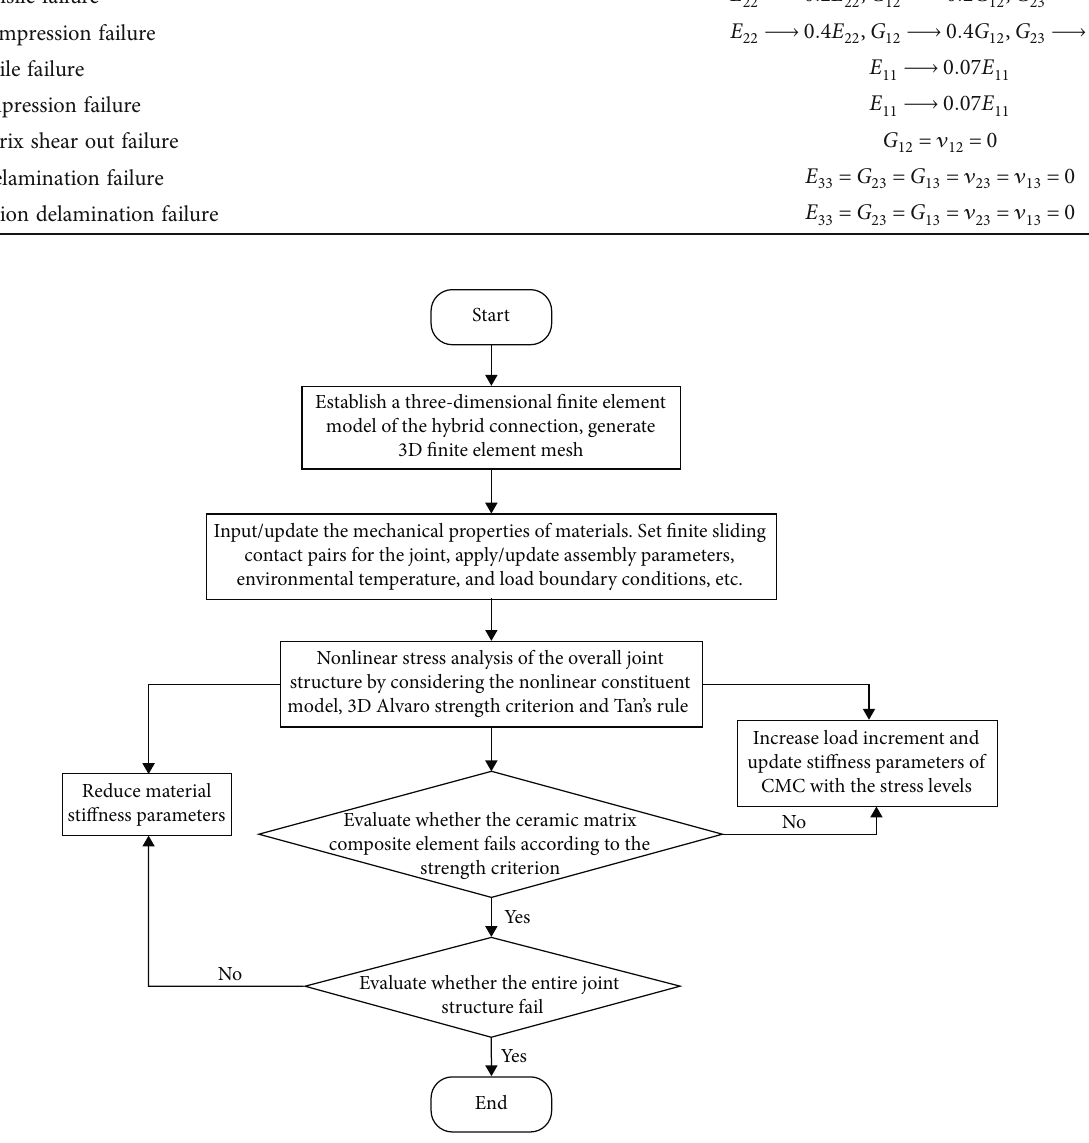
Figure 3: Flowchart for progressive damage analysis of the hybrid joint with two series